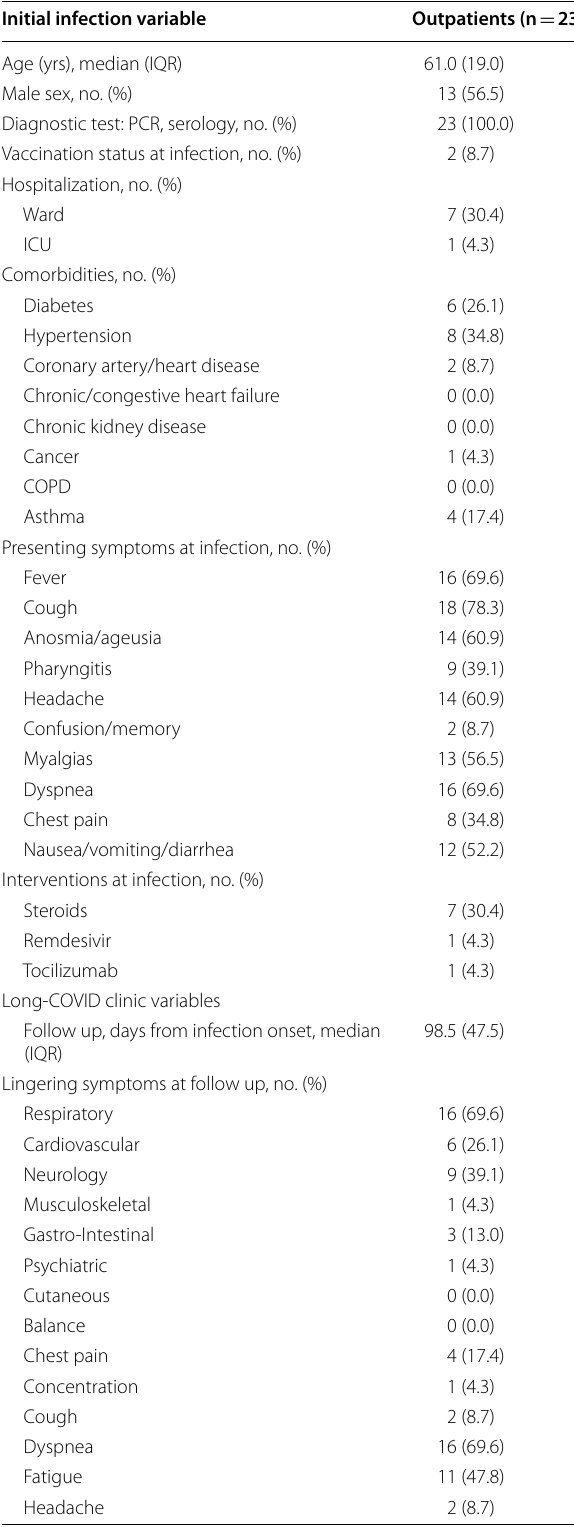
Table 1 Long COVID-19 outpatient demographics and clinical